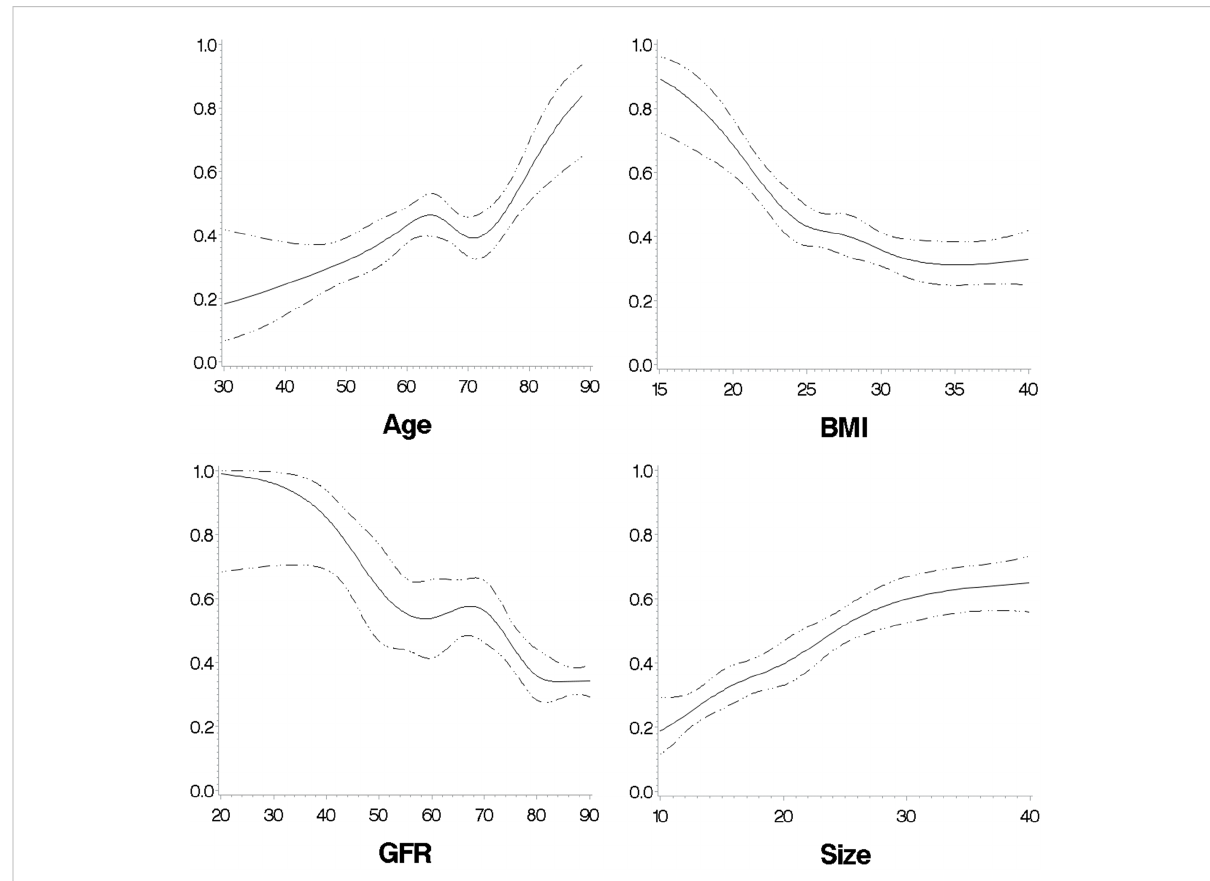
FIGURE 8 The predicted probabilities for cortisol DST to be ≥ 50 nmol/L in relation to age, BMI, eGFR, and size of the AI in patients with unilateral AI. The fi gures are calculated with restricted cubic splines, and each of the variates is adjusted for the remaining three of the four variates.